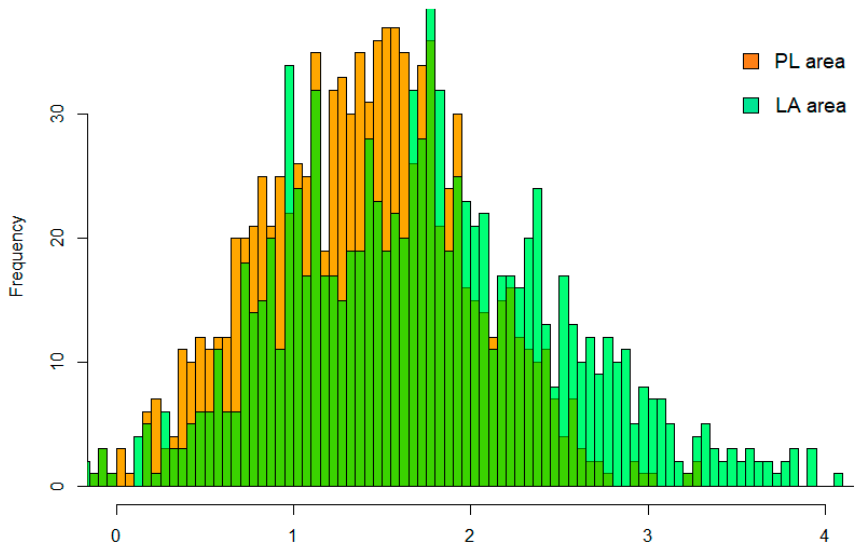
Figure 6. H istogram distribution of the PL R 0 values (orange) and LA R 0 values